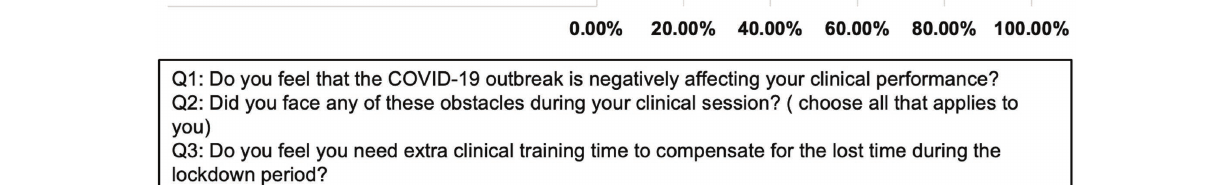
FIGURE 4 | Student’s responses to the survey on the impact of COVID-19 pandemic on the clinical dental performance. The corresponding questions are as follows: Q1: Do you feel that the COVID-19 outbreak is negatively affecting your clinical performance? Q2: Did you face any of these obstacles during your clinical session? (Choose all that applies to you) Q3: Do you feel you need extra clinical training time to compensate for the lost time during the lockdown